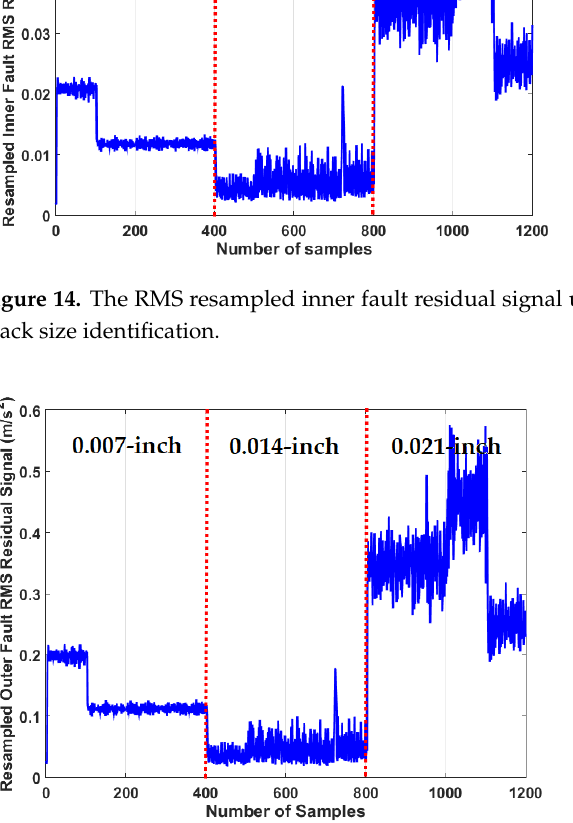
Figure 15. The RMS resampled outer fault residual signal using the proposed ADT algorithm for crack size identification.